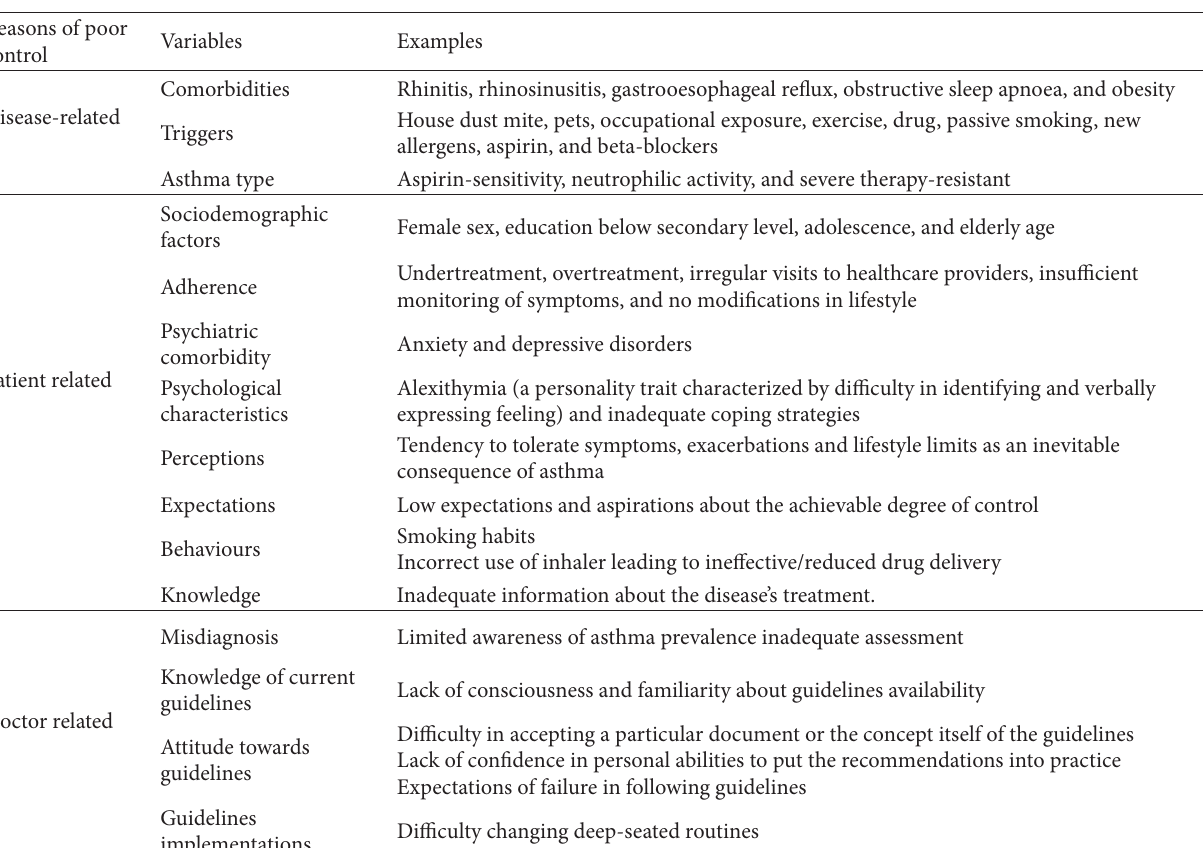
Table 1: Factors that influence the achievement and the of asthma control